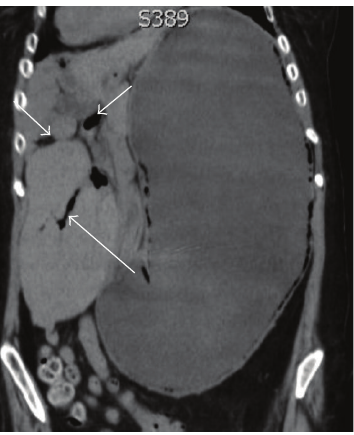
Figure 3: Portal venous gas on CT scan, coronal reformat (arrows).